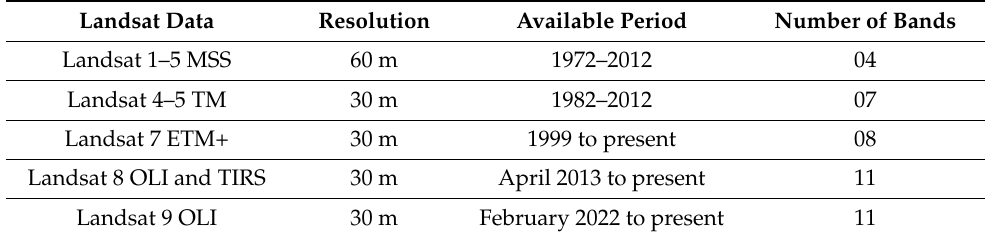
Table 1. Landsat data availability (https://earthexplorer.usgs.gov/, accessed on 2 May 2022). Landsat Data Resolution Available Period Number of Bands